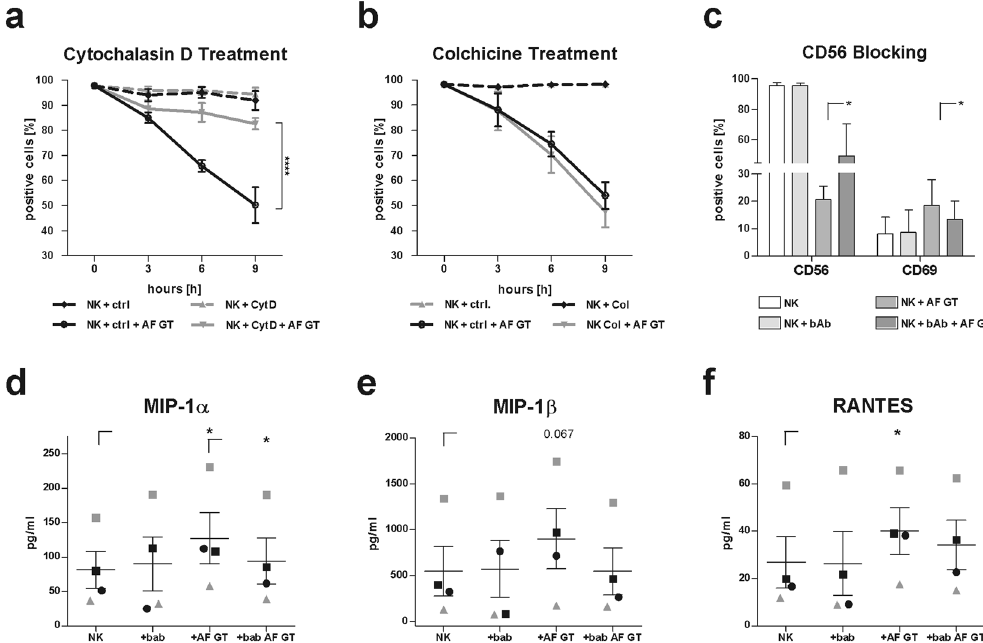
Figure 7. CD56 mediated fungal recognition is dependent on actin and CD56 blocking inhibits NK cell function. NK cells were incubated with ( a ) cytochalasin D (Cyt. D, n = 4), ( b ) colchicine (Col., n = 3) and ( c ) CD56 blocking antibody (bAb, n = 4) prior to co-cultivation with the fungus (AF GT). Percentage of CD56 positive cells was determined after an incubation with the fungus for 0, 3, 6, and 9 h. A paired student’s t-test was performed to compare NK + ctrl + AF GT against NK + CytD + AF GT or NK + Col + AF GT ( a , b ). Control samples were cultured in the presence of the corresponding control solution. Percentage of CD56 and CD69 positive cells was assessed after a co-cultivation for 9 h. CD56 and CD69 expression was analysed using flow cytometry. NK cells were defined as NKp46 + CD3 − . Supernatants derived from CD56 blocking experiments were analysed by ProcartaPlex TM multiplex immunoassays (n = 4, d – f ). The concentration of ( d ) MIP-1 α , ( e ) MIP-1 β and ( f ) RANTES detectable in supernatants is displayed in pg/ml. A paired student’s t-test was performed to compare ( c ) NK + AF GT against NK + bAb + AF GT and ( d – f ) NK against + AF GT and + AF GT against + bAb AF GT. Data are represented as mean ± SEM. Significant differences are indicated by an asterisk ( * p < 0.05, **** p < 0.001).